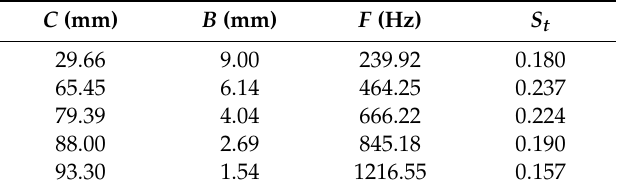
Table 5. Vortex-shedding frequency corresponding to each trailing-edge thickness.